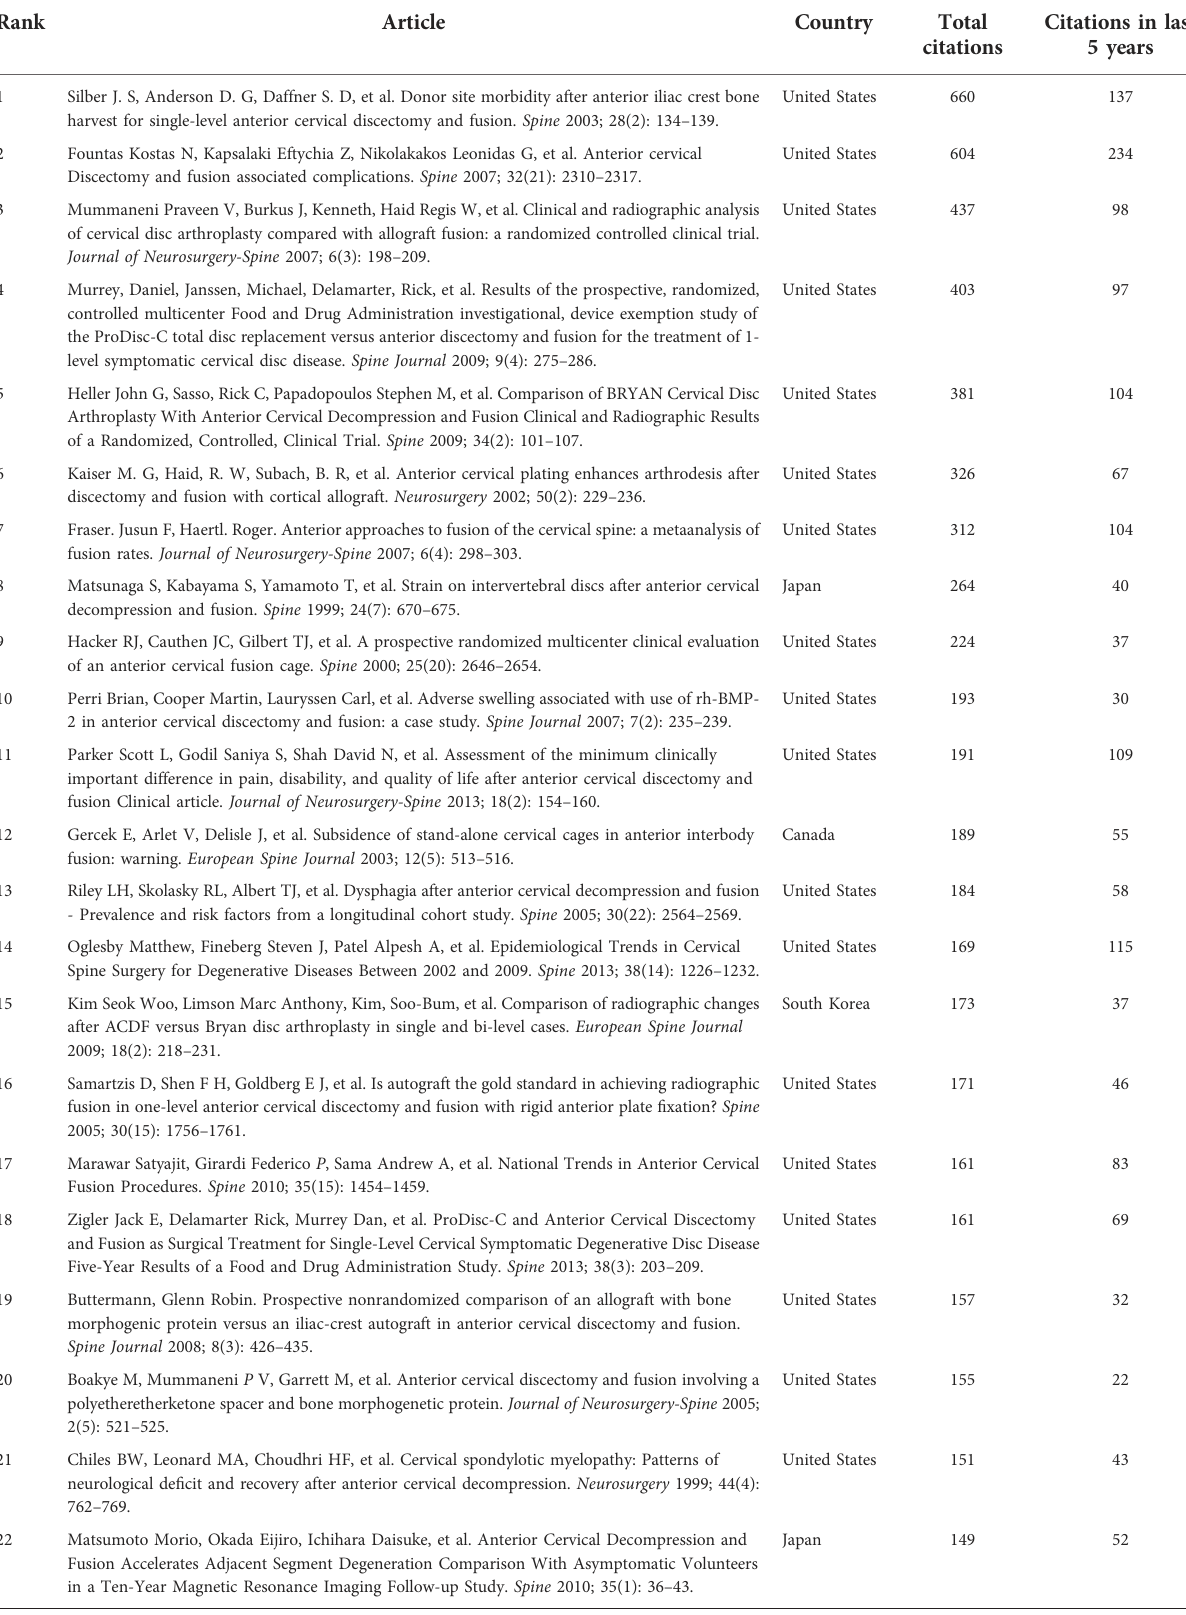
TABLE 1 List of the 100 most-cited articles in anterior cervical decompression and fusion.